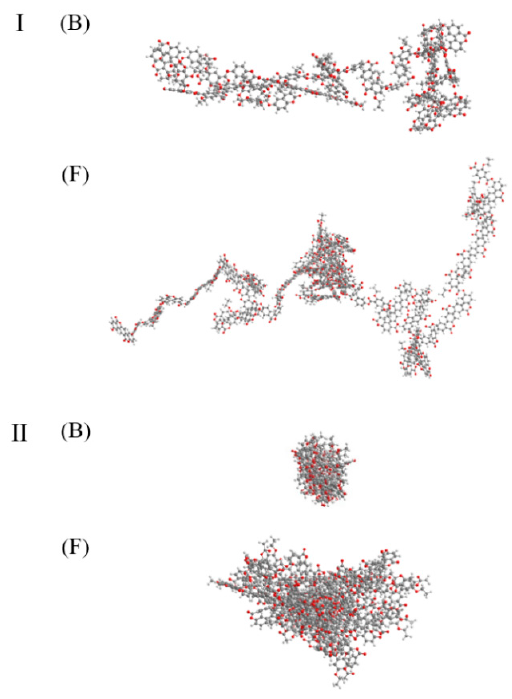
Figure 8. Comparison of the 3-D chemical structures of samples B and F in two TLCP